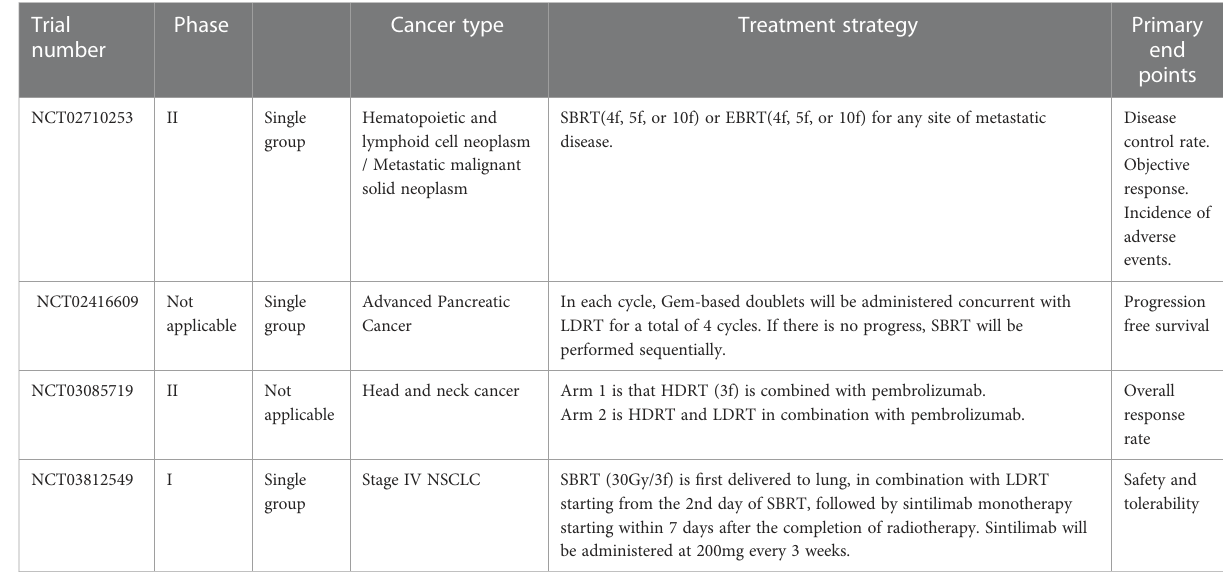
TABLE 1 Clinical trials of multimodal radiotherapy (HDRT and LDRT) in advanced